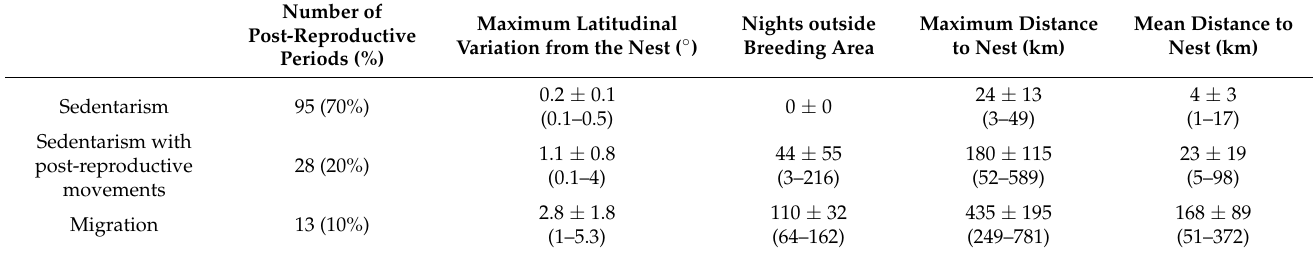
Table 1. Movement parameters (maximum distance to nest, mean distance to nest, and daily traveled distance) broken down by strategies (sedentarism, sedentary with post-reproductive movements, and migration). The sample unit was the post-reproductive period (n = 136), so one individual with several years can be found in different strategies. Values are expressed as mean ± standard deviation (minimum–maximum).